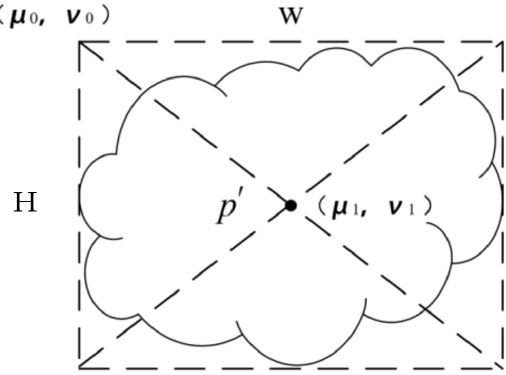
Figure 5. Plane location based on the prediction box detected by the YOLO V4-Tiny method. Where, ( µ ) is the vertex coordinate of the prediction box detected by the YOLO V4-Tiny model, and W 0 , v 0 and H are the width and height of the prediction